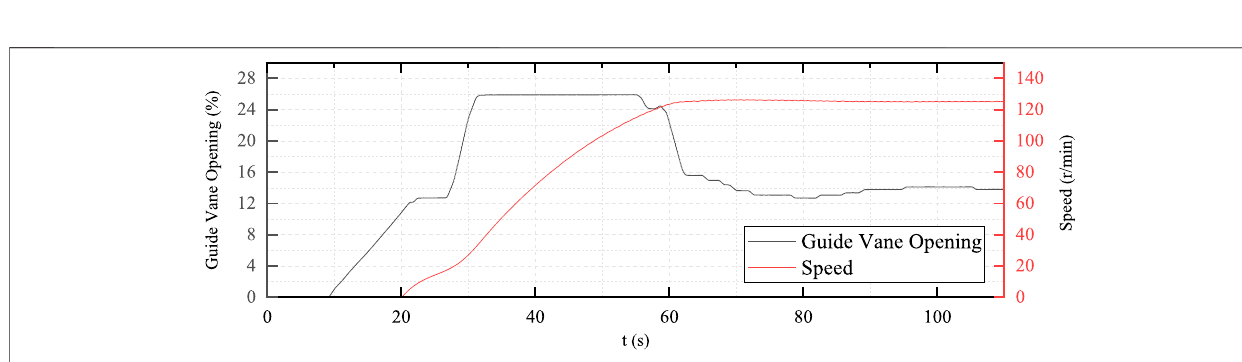
FIGURE 10 | The dynamic strain – stress curve with the guide vane opening (single-stage acceleration).